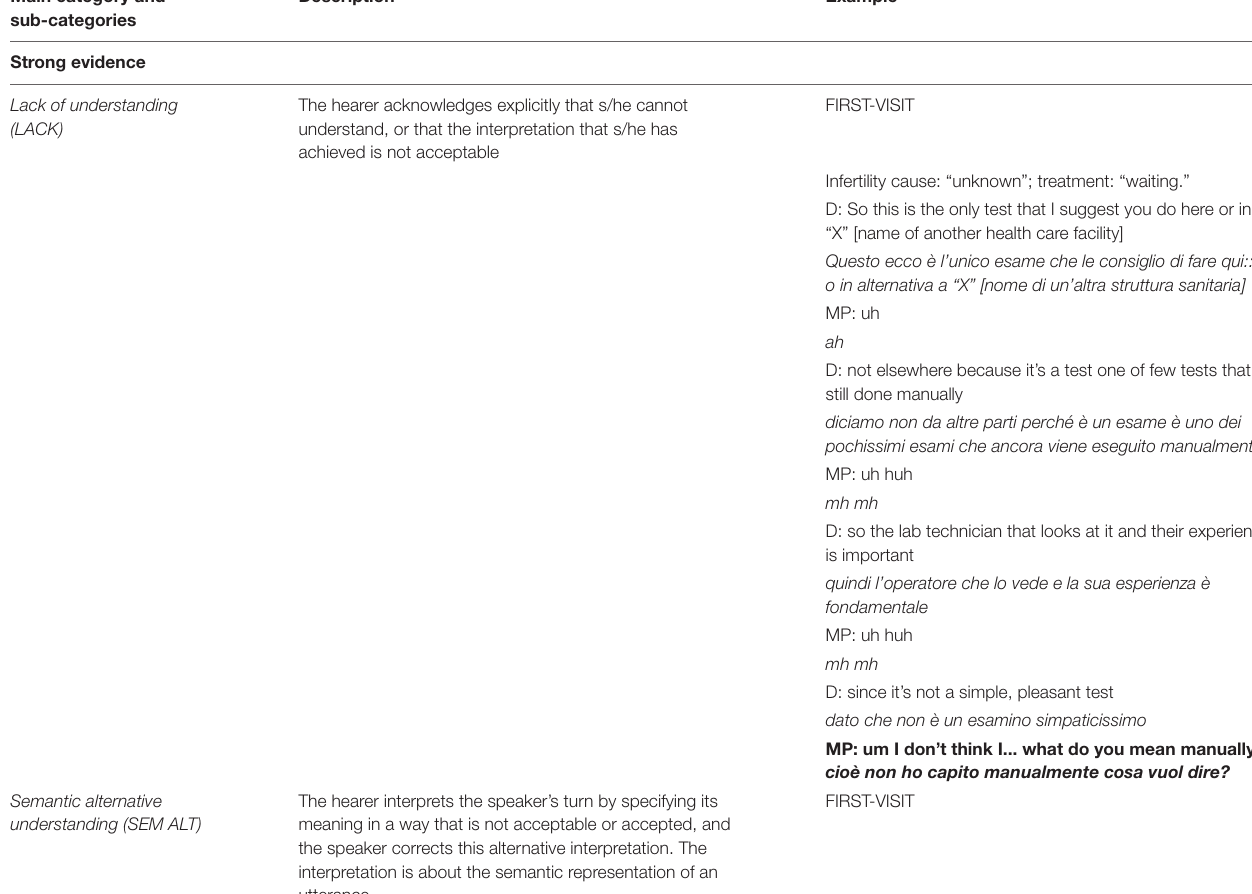
TABLE 2 | Coding categories (name, description, example). Main category and sub-categories